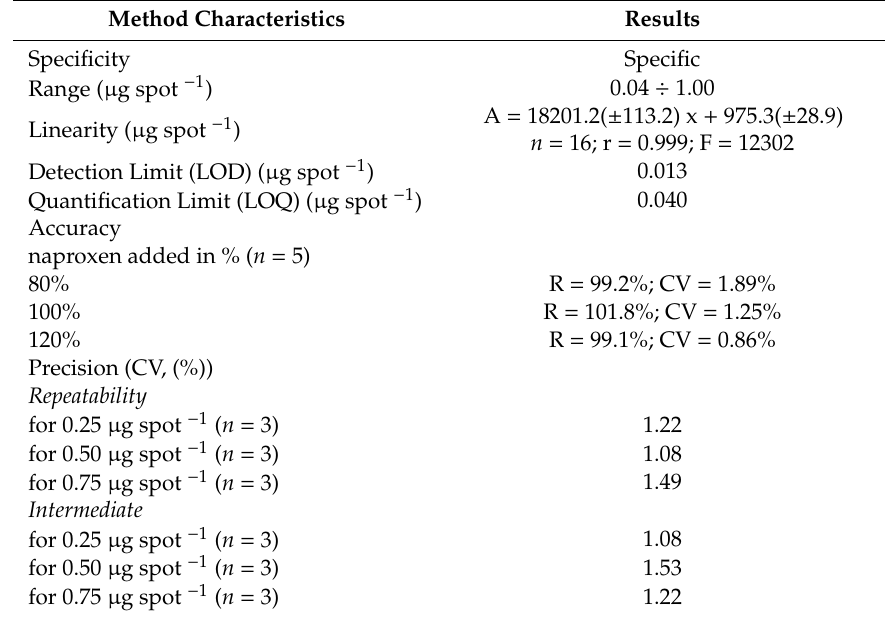
Table 3. Validation of TLC-densitometric method for naproxen analyzed using mobile phase A a . Method Characteristics